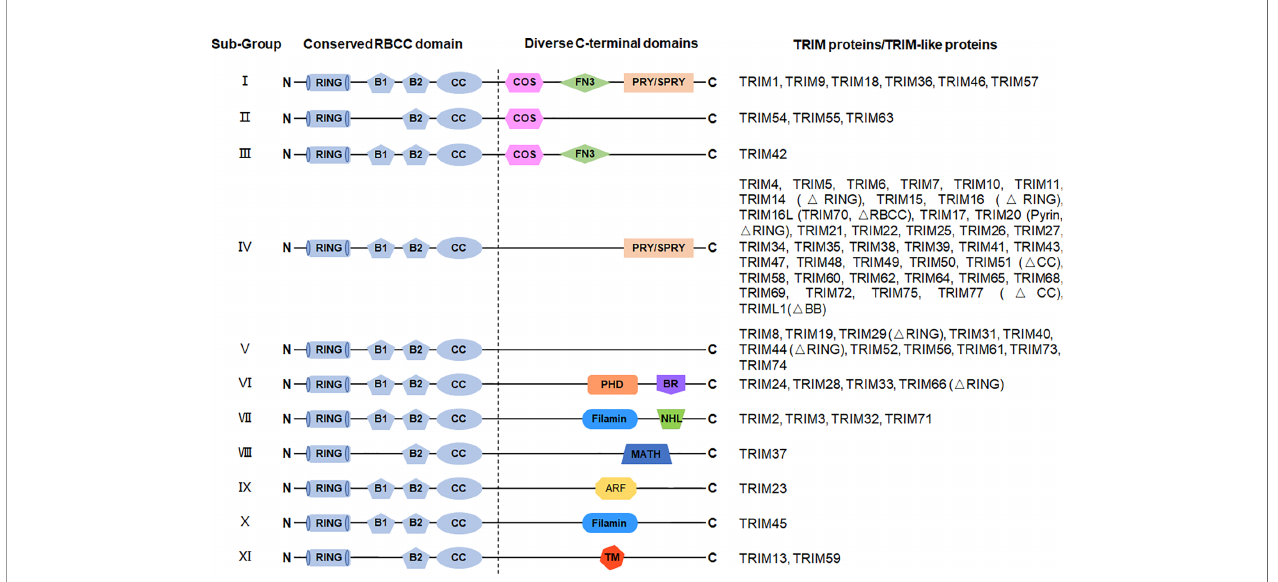
FIGURE 1 | Structures of TRIM protein. TRIM proteins are generally divided into 11 subgroups depending on their variable C-terminal domains, including C-terminal subgroup one signature (COS) domain, fi bronectin type 3 (FN3) domain, SPIa and the ryanodine receptor (SPRY) domain, SPRY-associated domain (PRY), plant homeodomain (PHD), bromodomain (BR), fi lamin domain, NHL repeats (NHL) domain, meprin and tumor necrosis factor receptor – associated factor homology (MATH) domain, ADP-ribosylation factor (ARF) domain, and transmembrane (TM) domain. The N-terminal domains are conserved among TRIM proteins, containing a RING domain, a B-box 1 (B1) and/or a B-box 2 (B2) domain, and a CC domain. TRIM-like proteins lacking typical domain(s) are indicated in